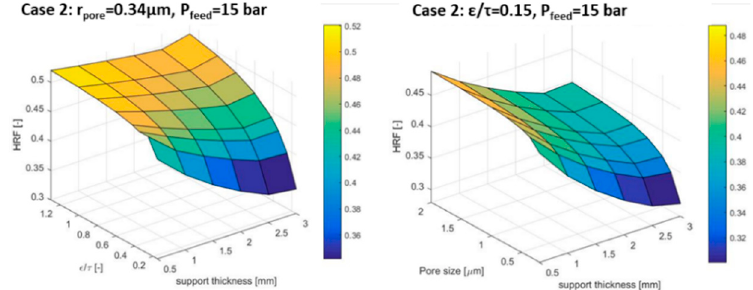
Figure 4. HRF comparison for the considered cases.